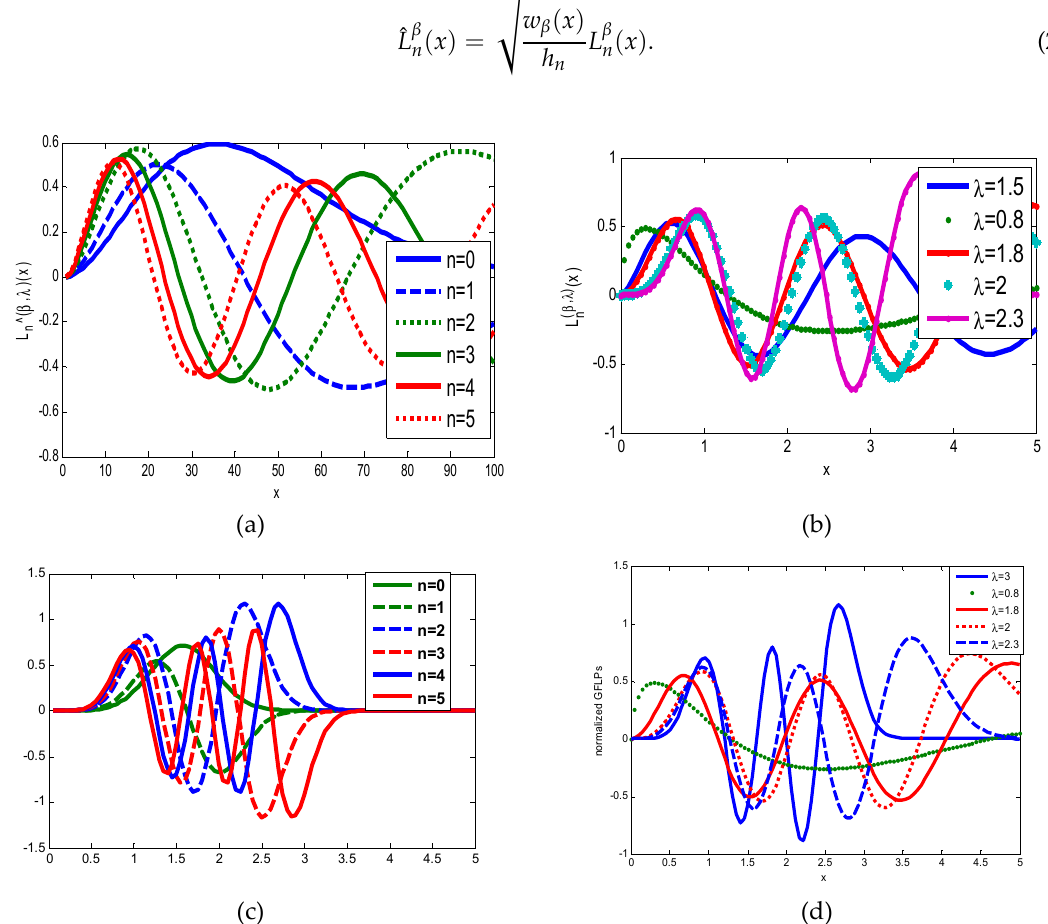
Figure 4. ( a ) Shows GFLPs with different orders. ( b ) Shows GFLPs with different value of λ . ( c ) Shows normalized GFLPs with different orders. ( d ) Shows normalized GFLPs with different values of λ .